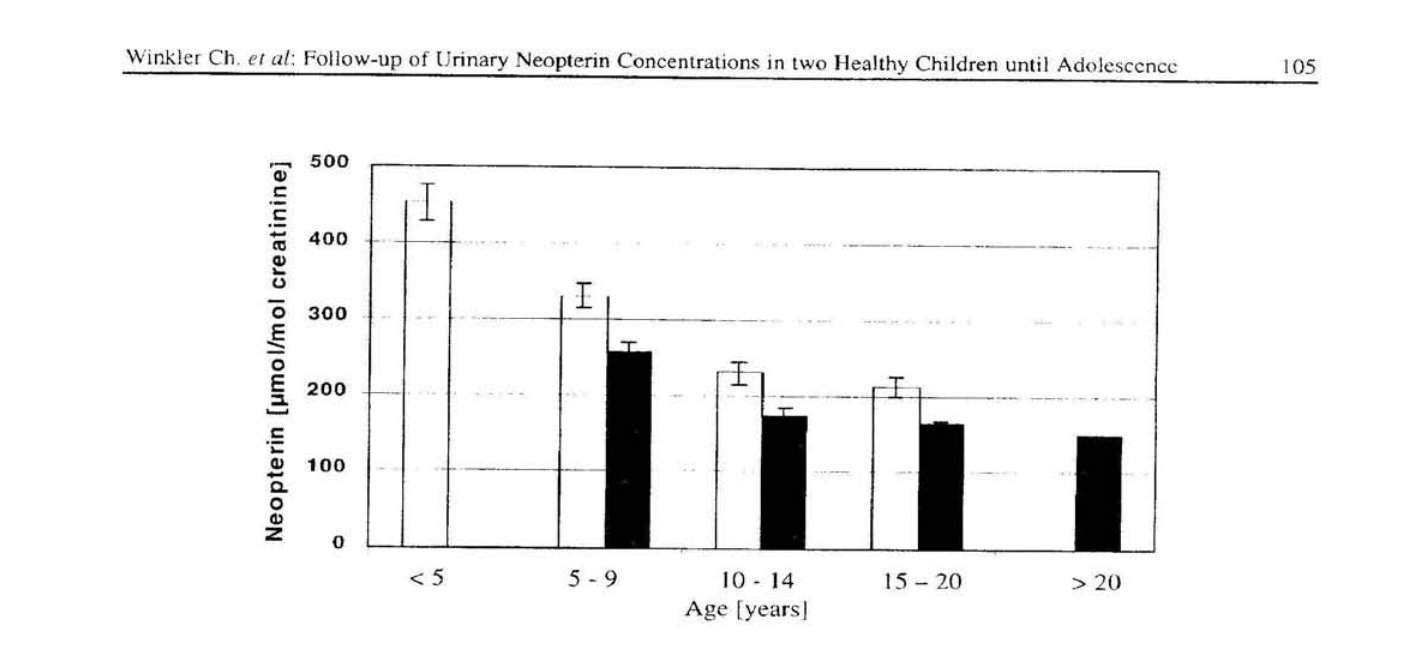
Figure 3. Urinary• neopterin concentrations (mean ± S.E.M.) are shown for intervals of 5 years in a girl from 7 to 23 years (black bars) and from a buy ( white bars) from 0 to 18 years, 5 age groups are depicted (urinarv spec- imens collected during an infectious episode were excluded; concentrations in the female were not different form the male, at all occasions) 350.4 μπιοΐ/mol creatinine (S.D.: 271.6; range: 116 - children (Fig. 2). Overlap of the two data sets show:; 1735). During the 18 years of follow-up a steady even more than with the crude data that measured decline of neopterin concentrations was apparent in neopterin concentrations in urines of the two ehiloicn both individuals, and overlap of the two data sets were almost indistinguishable (Fig. 1). shows thai measured neopterin concentrations in When grouping specimens according to 5 year-, urines of the two children were almost indistinguish- intervals, in the female neopterin concentrations bet- able (Fig. 1). ween 5 -10 years (mean ± S.D.: 266.3 ± 38.8 pmol/'mo! (185.8 ±45.5 pinol/mol creatinine; U = 3.097, ρ <0.01 : Fig. 3). The same behaviour of neopterin concentra- tions was apparent in the male volunteer, concentra-